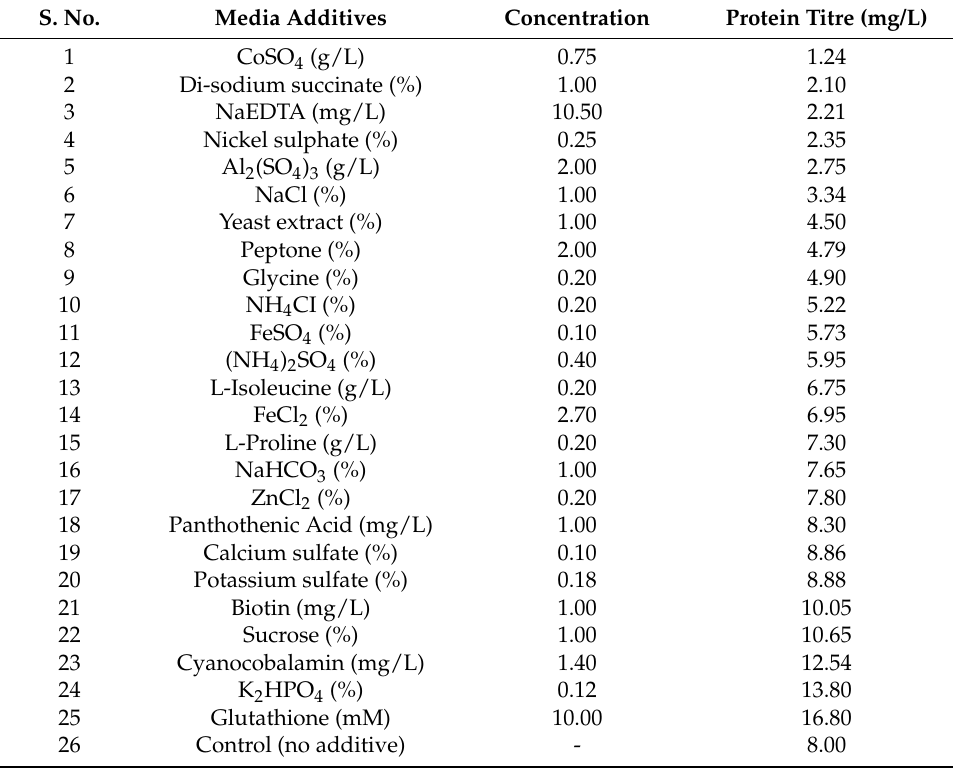
Table 3. The protein titre obtained as a result of the addition of various nutrient additives as found by the one factor at a time (OFAT) approach. S.